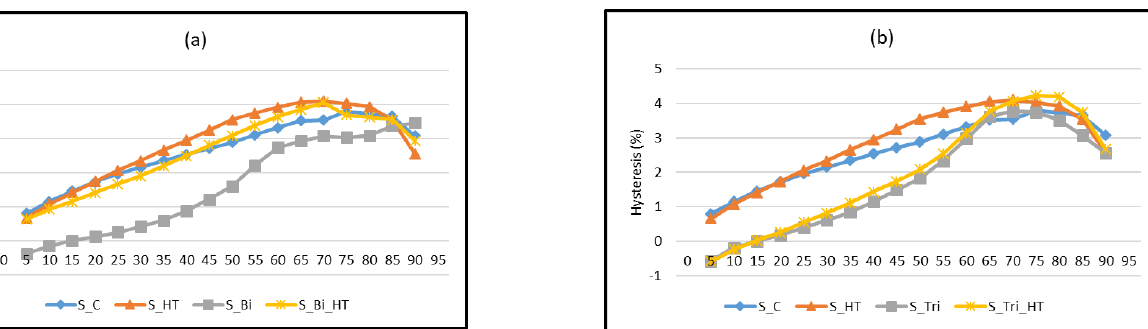
Figure 3. Hysteresis results for spruce, showing ( a ) effects of bicine treatment and ( b ) effects of tricine treatment, respectively.